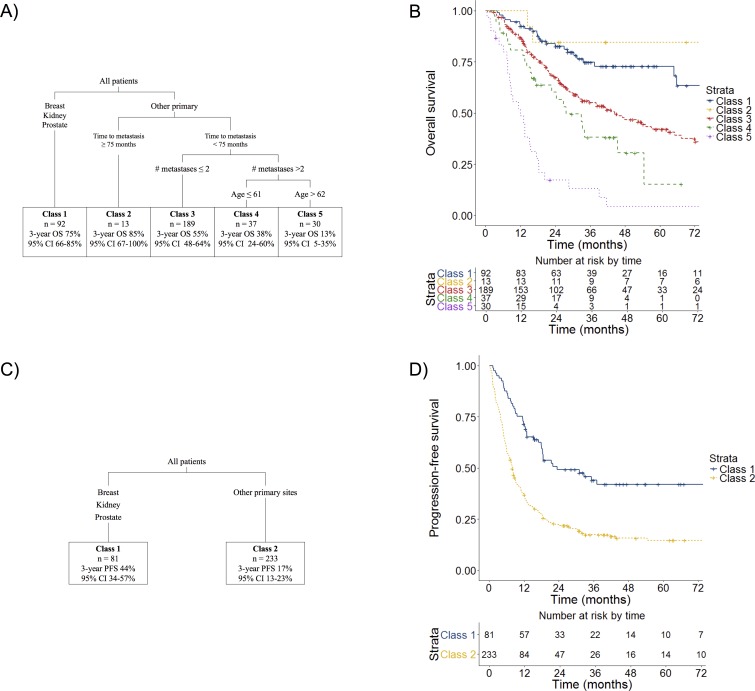
Recursive partitioning models for overall survival and progression-free survival.For overall survival, recursive partitioning allowed stratification of patients into five prognostic classes (A). Overall survival was well-stratified based on RPA class (B); log-rank p < 0.01. For progression-free survival, recursive partitioning allowed stratification of patients into two prognostic classes (C). Progression-free survival was well-stratified based on RPA class (D); log-rank p < 0.01.